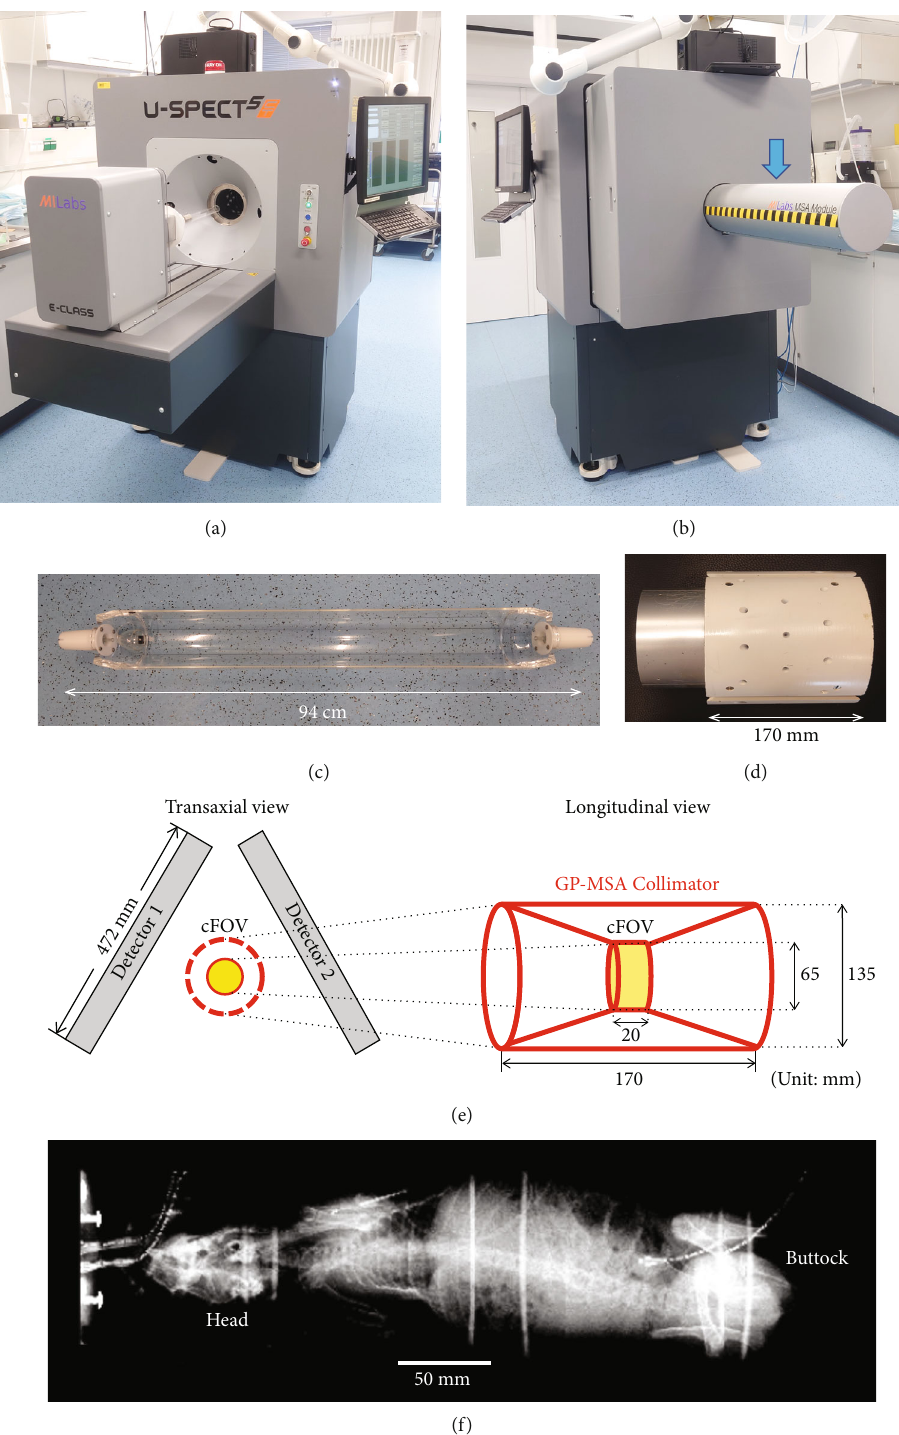
Figure 1: The overview of U-SPECT5/CT E-class. (a) The front side of the system. (b) The back side of the system. A tubular protrusion on the back side (blue arrow) can hold a 94cm long bed for medium-sized animals. (c) Photo of bed for medium-sized animals. (d) General-purpose medium-sized animal (GP-MSA) collimator. (e) Geometric illustration of GP-MSA collimator in the two stationary detectors. The bore diameter of GP-MSA collimator is 135mm, and the transaxial size of center fi eld-of-view (cFOV) is 65mm. (f) Scout view of a rabbit scanned with X-ray system combined with the SPECT